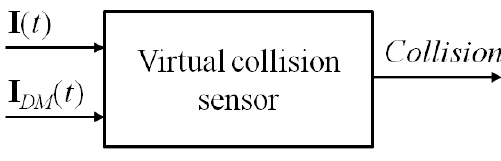
Figure 1. Virtual collision sensor